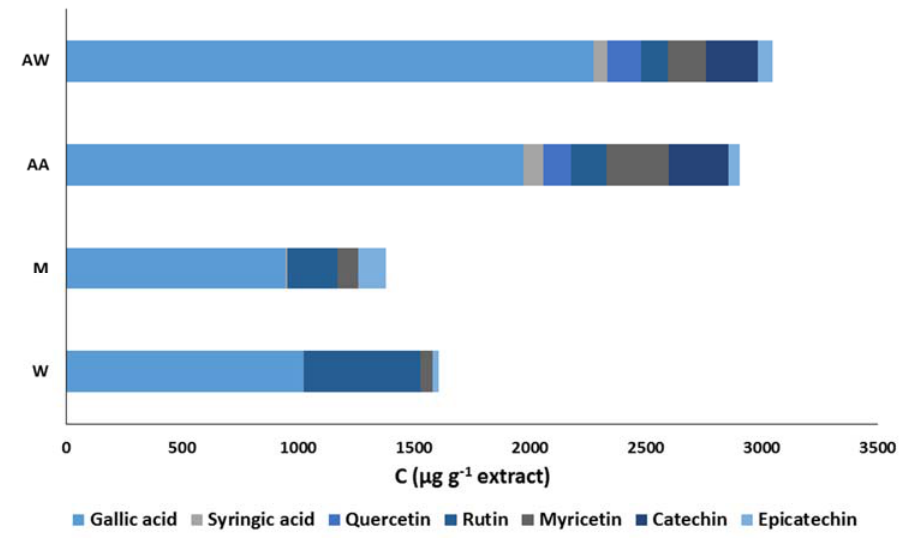
Figure 4. Comparison of the phenolic composition of carob extracts. The symbols W, M, AW, AA represent the water, methanol, acetone–water, and acidic acetone extracts, respectively.